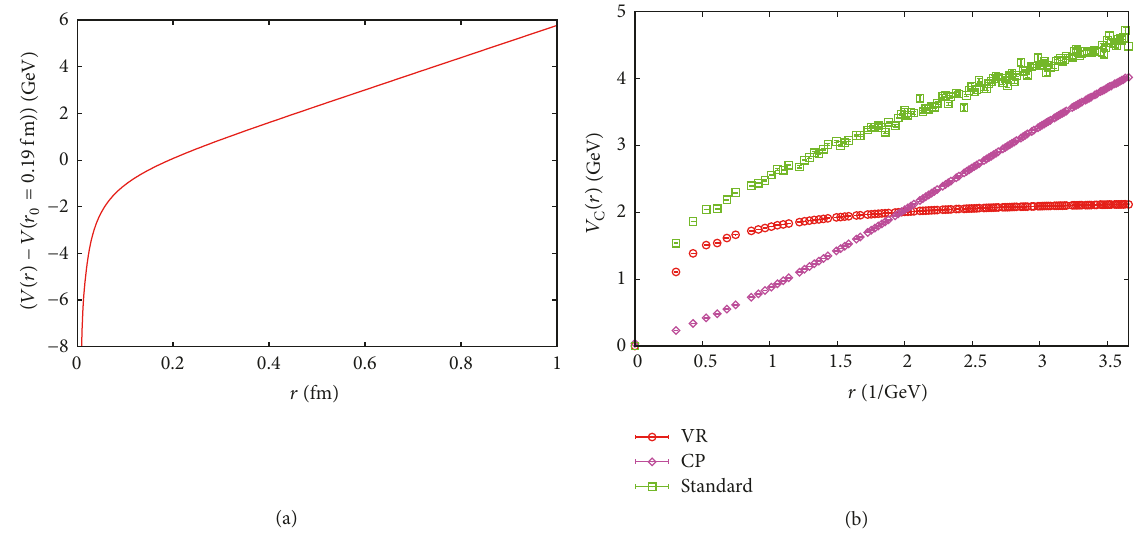
Figure 10: (a) Non-Abelian Coulomb potential (23) obtained within the variational approach [25]. (b) Standard non-Abelian Coulomb potential (green boxes) compared to the potential obtained after vortex removal (red circles) and center projection (violet diamonds) [29].